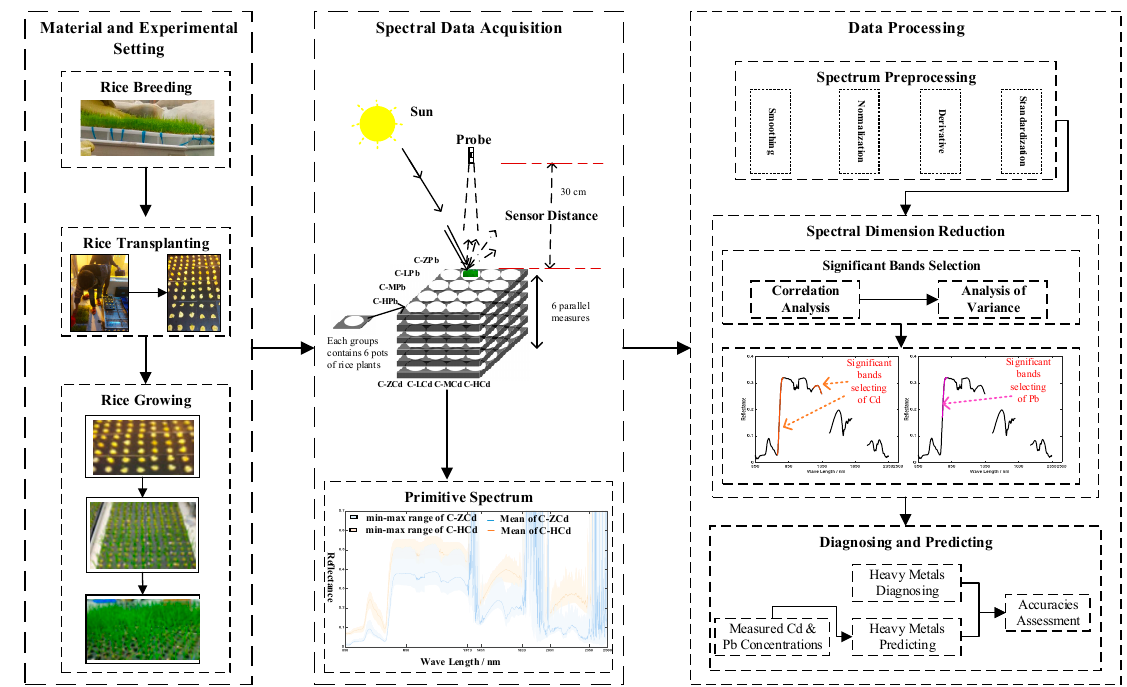
Figure 2. Workflow of the Experiment.